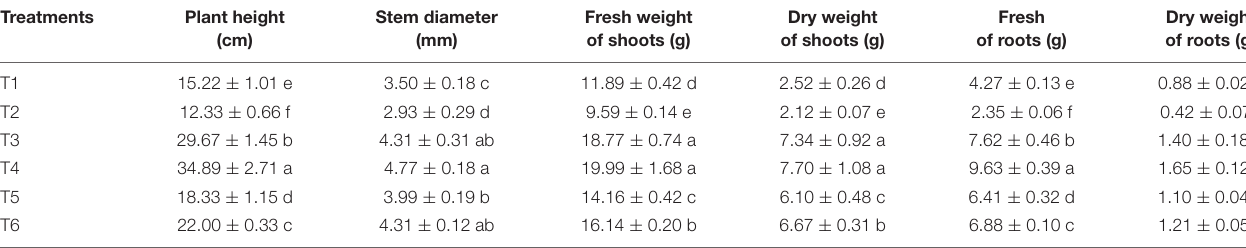
TABLE 3 | Effects of 1% HA addition on the morphological parameters of cucumber seedlings. Treatments